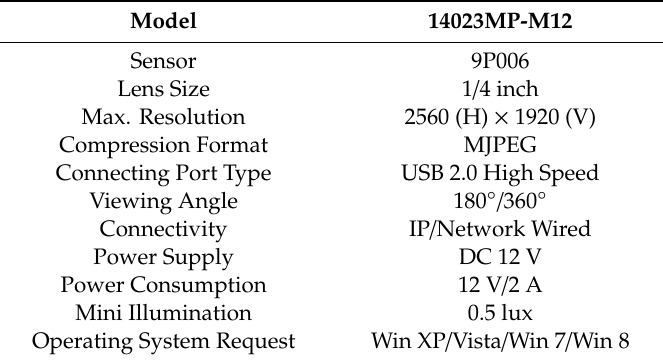
Table 3. Specifications of the wide-angle lens